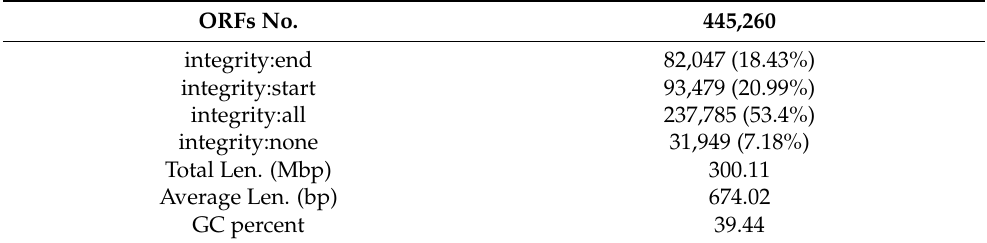
Table 3. Gene catalogue basic information. ORFs No. indicates the number of genes in the gene